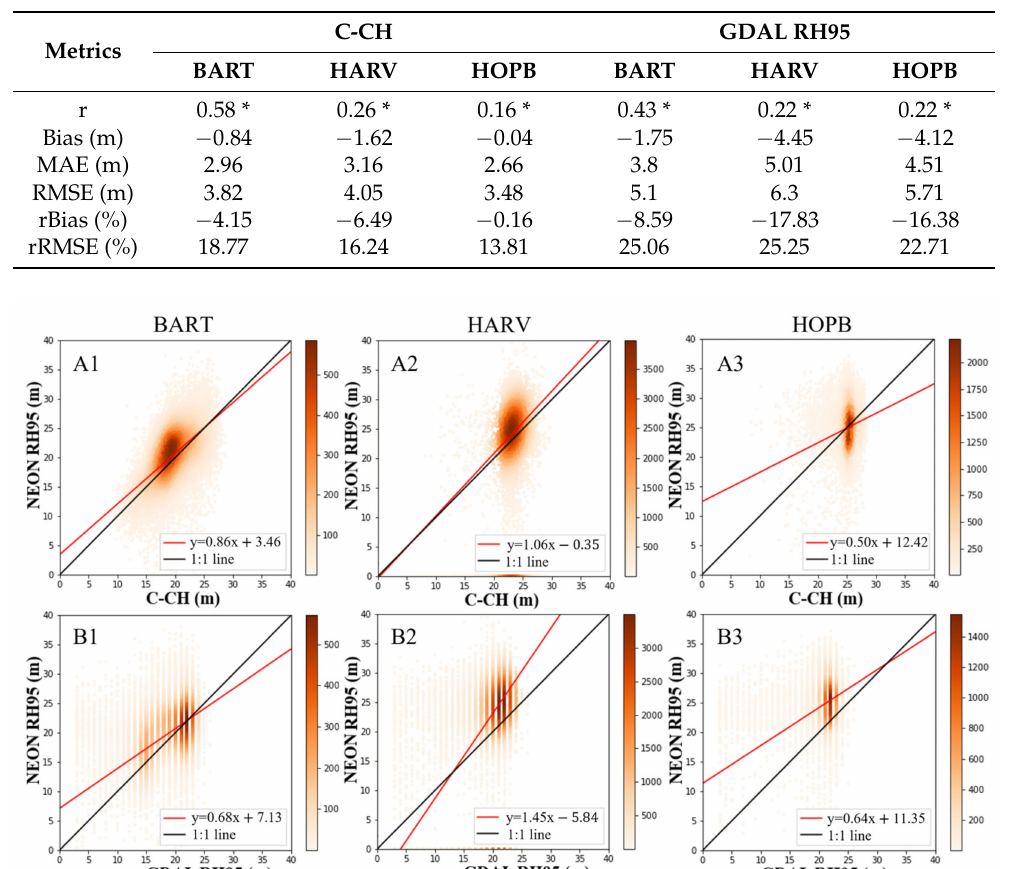
Table 4. Accuracies of the FPSF-CH for canopy height mapping (C-CH) and GDAL RH95 compared with NEON RH95. The negative bias represents an under-estimation compared with NEON RH95. The asterisk represents a significant correlation ( p < 0.05).